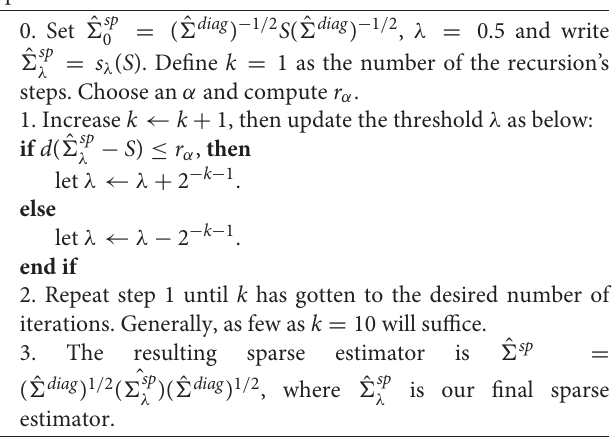
Algorithm 1 Concentration inequality-based estimation of sparse covariance